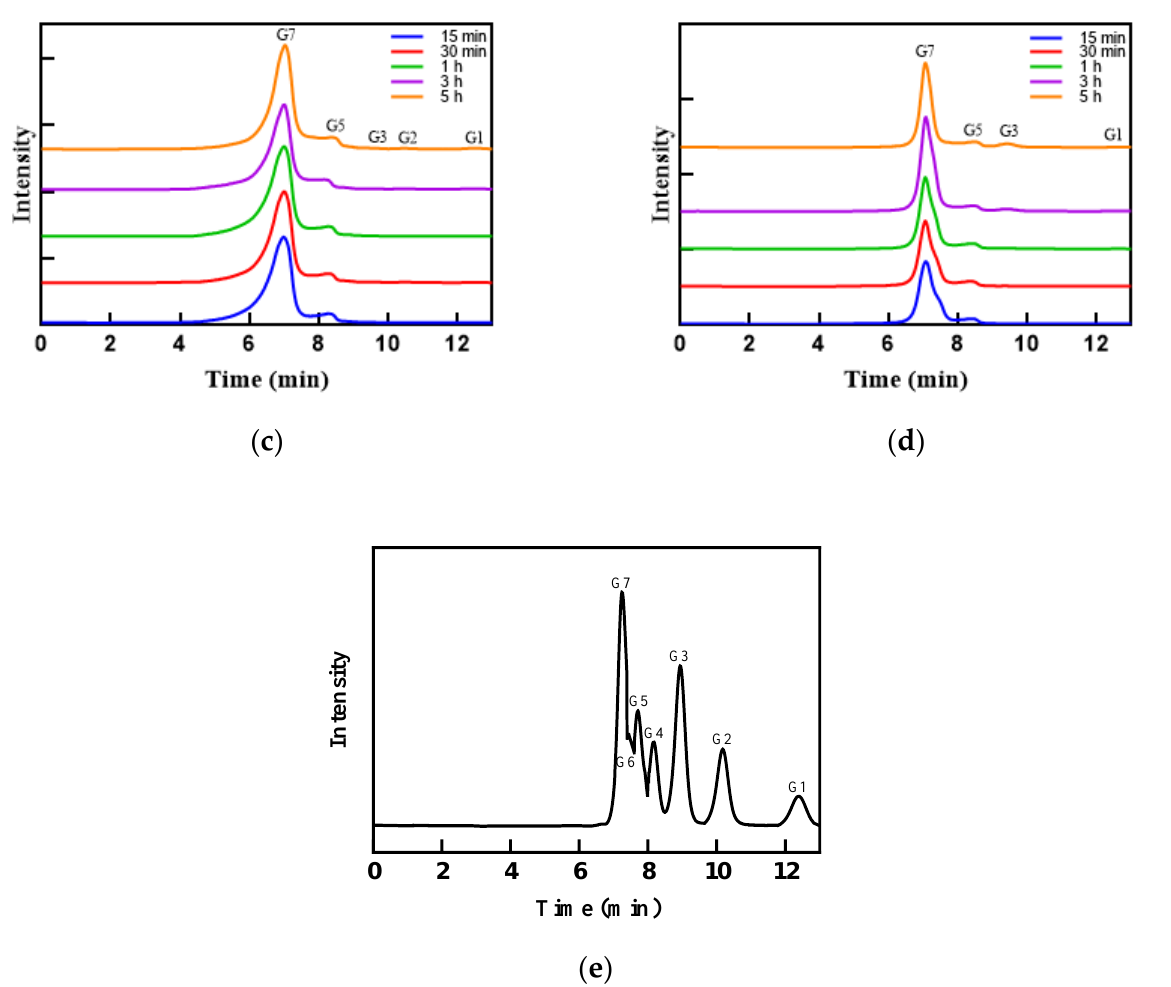
Figure 5. HPLC plots of Pul-HJ21 and Pul-HJ ∆ 782 for the enzymatic digestion of pullulanase and soluble starch at different times. ( a ) HPLC analysis of Pul-HJ21 during the enzymatic digestion of soluble starch at different times; ( b ) HPLC analysis of Pul-HJ21 during enzymatic digestion of pullulan at different times; ( c ) HPLC analysis of Pul-HJ ∆ 782 during the enzymatic digestion of soluble starch at different times; ( d ) HPLC analysis of Pul-HJ ∆ 782 during the enzymatic digestion of pullulan at different times; and ( e ) elution peaks of reference standards.